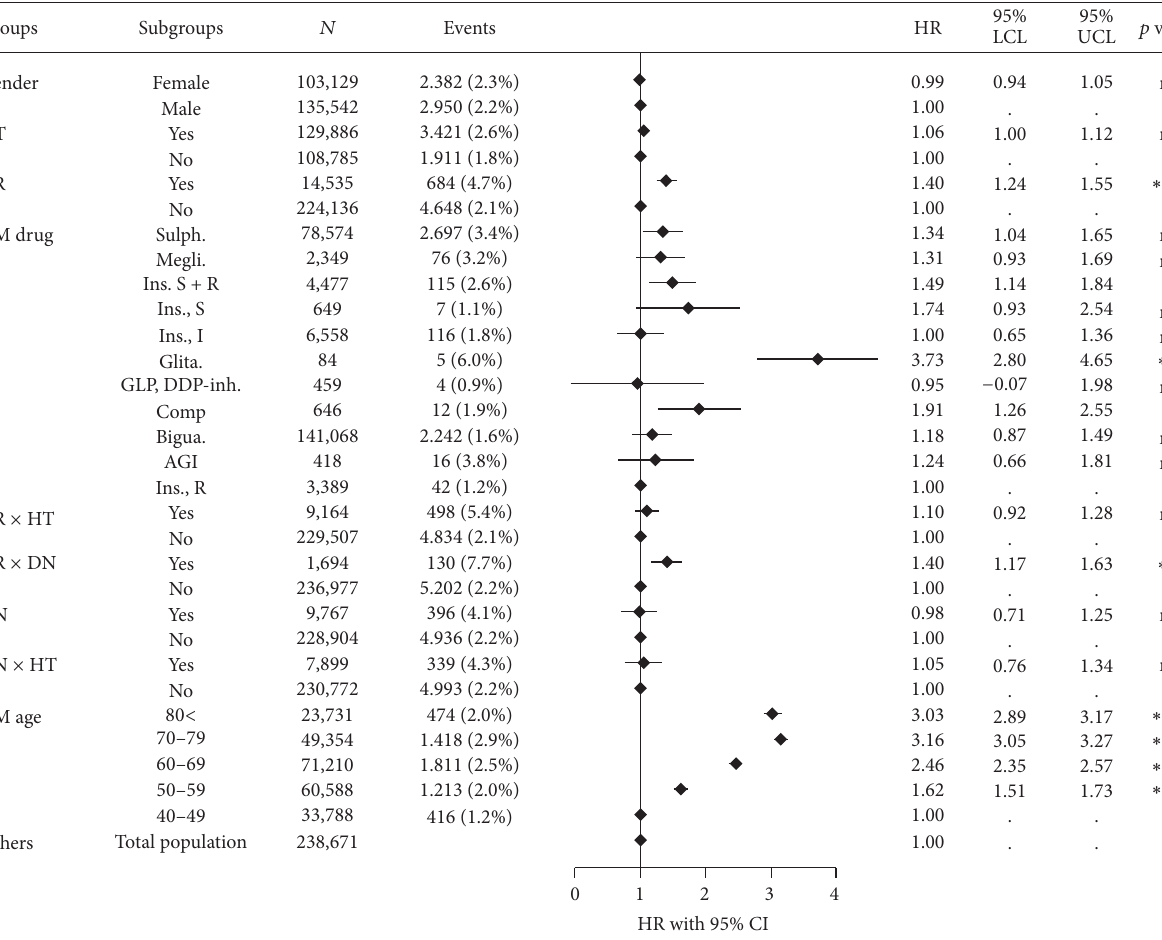
Figure 3: Hazard ratios for glaucoma development in patients treated with antidiabetic drugs. A range of confounding factors, comorbidity, concomitant medications factors, age, and gender are being adjusted for. The underlying data represents patients ≥ 40 years of age. For data on the total diabetic population, see Table 2. HR: hazard ratio; 𝑁 : number of individuals; events: number of patients with glaucoma; CL: confidence limit. ∗ Significant on the 5% level. ∗∗ Significant on the 1% level. ∗∗∗ Significant at the 0.1%